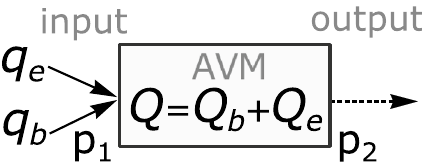
Figure 1. AVM embolization model representation. Q —volume flow rate of two-phase mixture; Q b and Q e —volume flow rates of blood and embolic agent inside AVM; q b and q e —volume flow rates of blood and